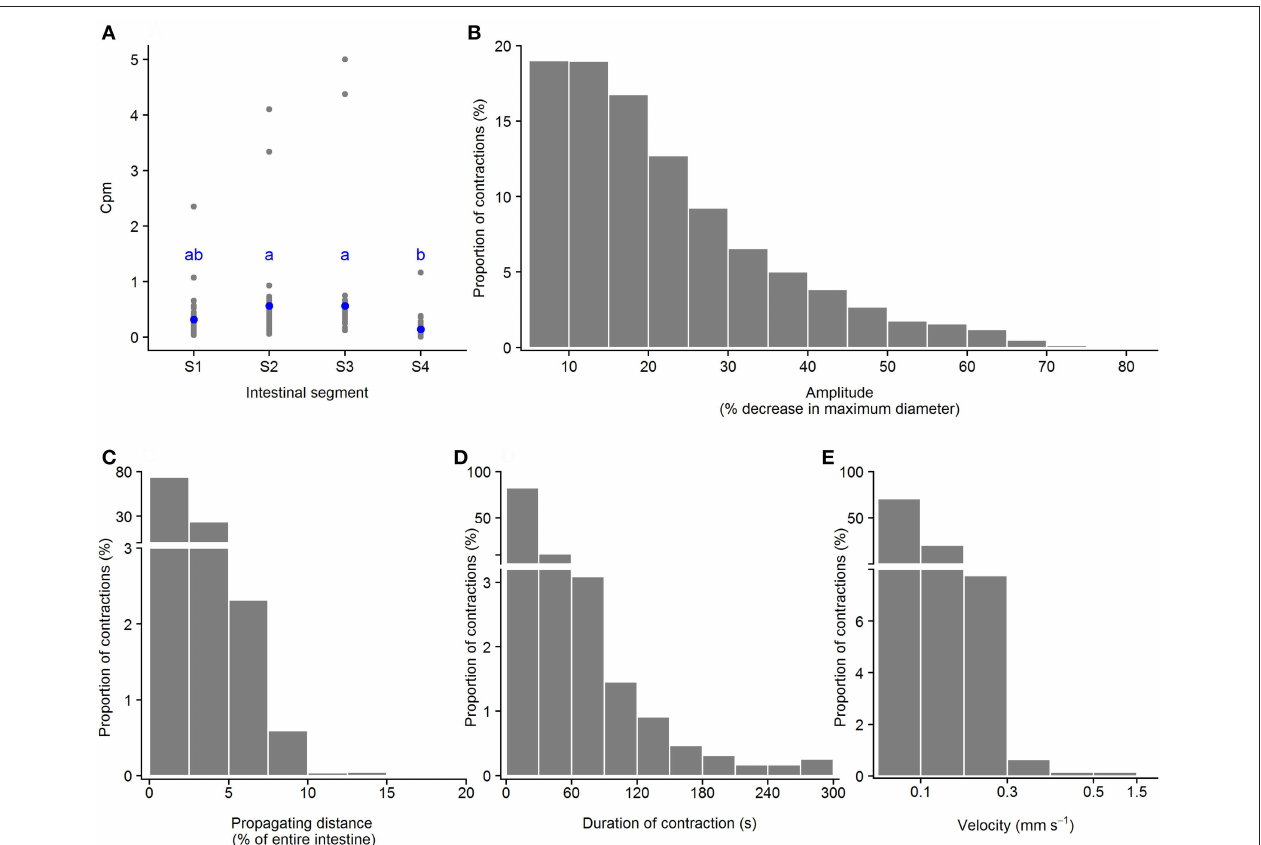
FIGURE 7 | Motility parameters for slow propagating contractions in intestine of ballan wrasse juveniles. (A) Frequency of slow propagating contractions (contractions per min. per mm gut length, cpm) in the four intestinal segments (gray dots for individual values and blue dots for mean value calculated from 21 fish); letters denote difference between segments (ANOVA, Tukey post-hoc test). (B) Amplitude was converted from mm to a relative value (%) in relation to the maximum diameter of the intestinal position where the slow propagating contractions occurred; (C) Propagating direction; (D) Duration of contractions; (E) Propagating velocity of slow propagating contractions. (B–E) present histogram of data that was pooled from 21 fish. S1–S4, Segments 1–4 of the ballan wrasse